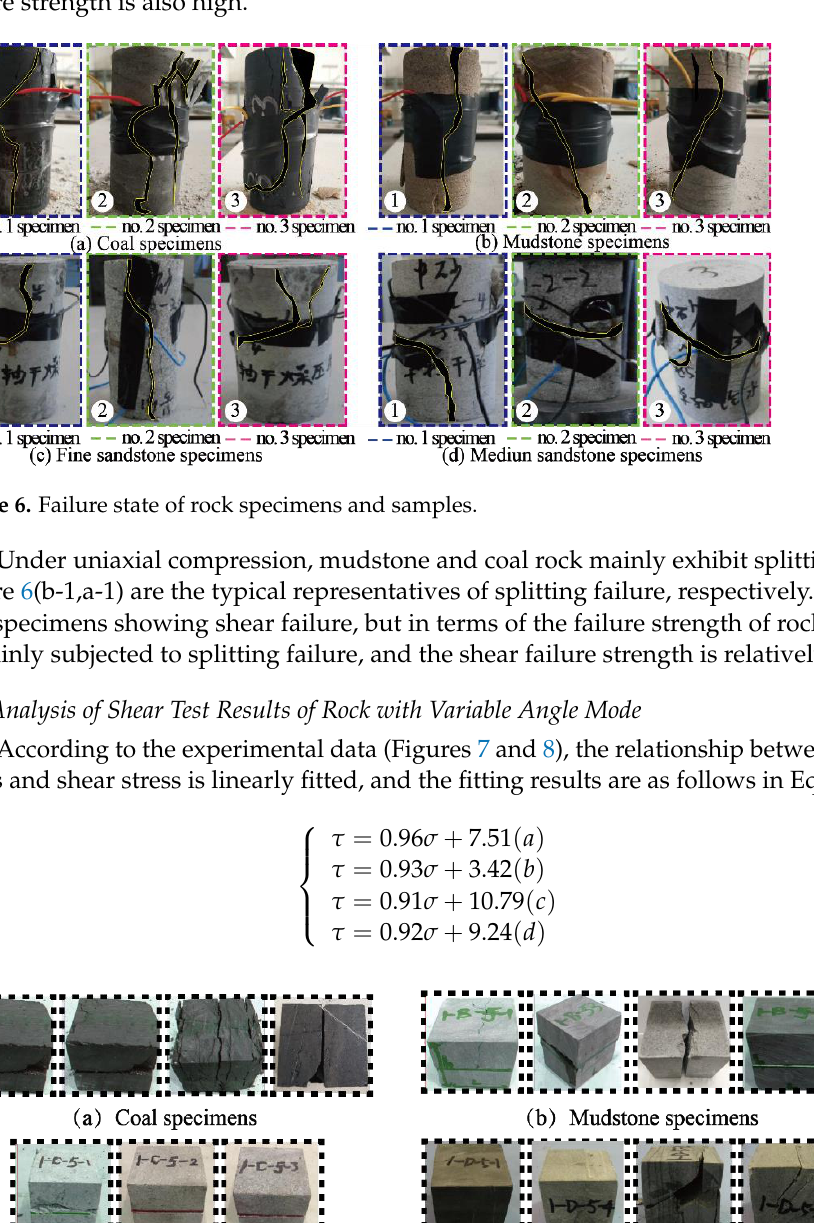
Figure 5. Stress – strain curves of rock specimens.